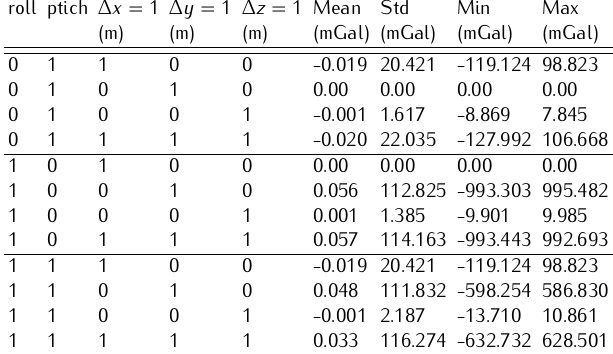
Table 1. The lever-arm simulation plans and their corresponding effects on the vertical acceleration. (The 0 and the 1 in the attitude columns represent their absence or appearance, respectively, in the simulation.)